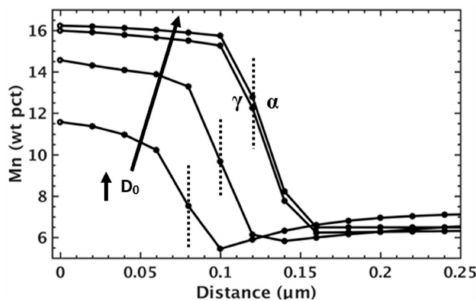
Figure 10. MICRESS ® predictions for Mn distributions across the α - γ interface after a 500 s isothermal hold at 650 ◦ C for simulations incorporating di ff erent Mn di ff usivity pre-factors ( D 0 ) for Mn di ff usivity in